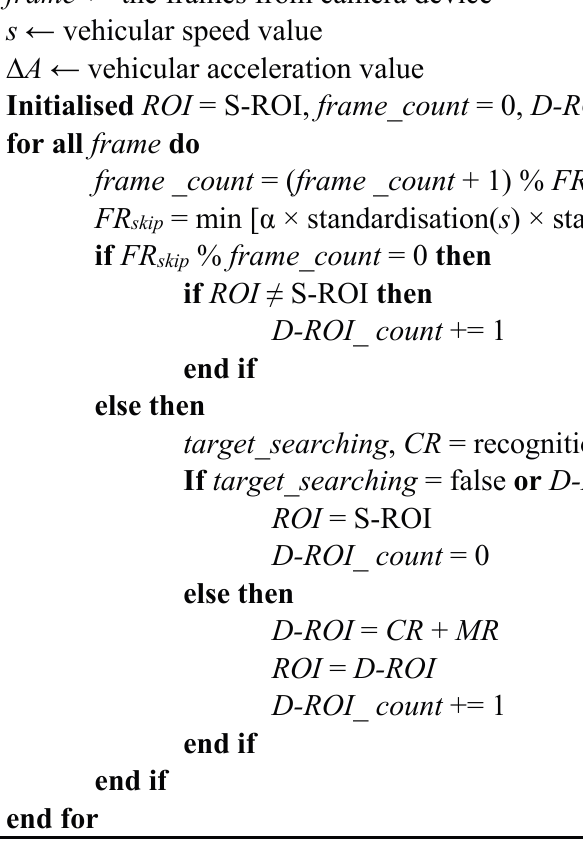
Algorithm 1. Pseudocode of D-ROI and DFS methods for minimizing computing load. frame ← the frames from camera